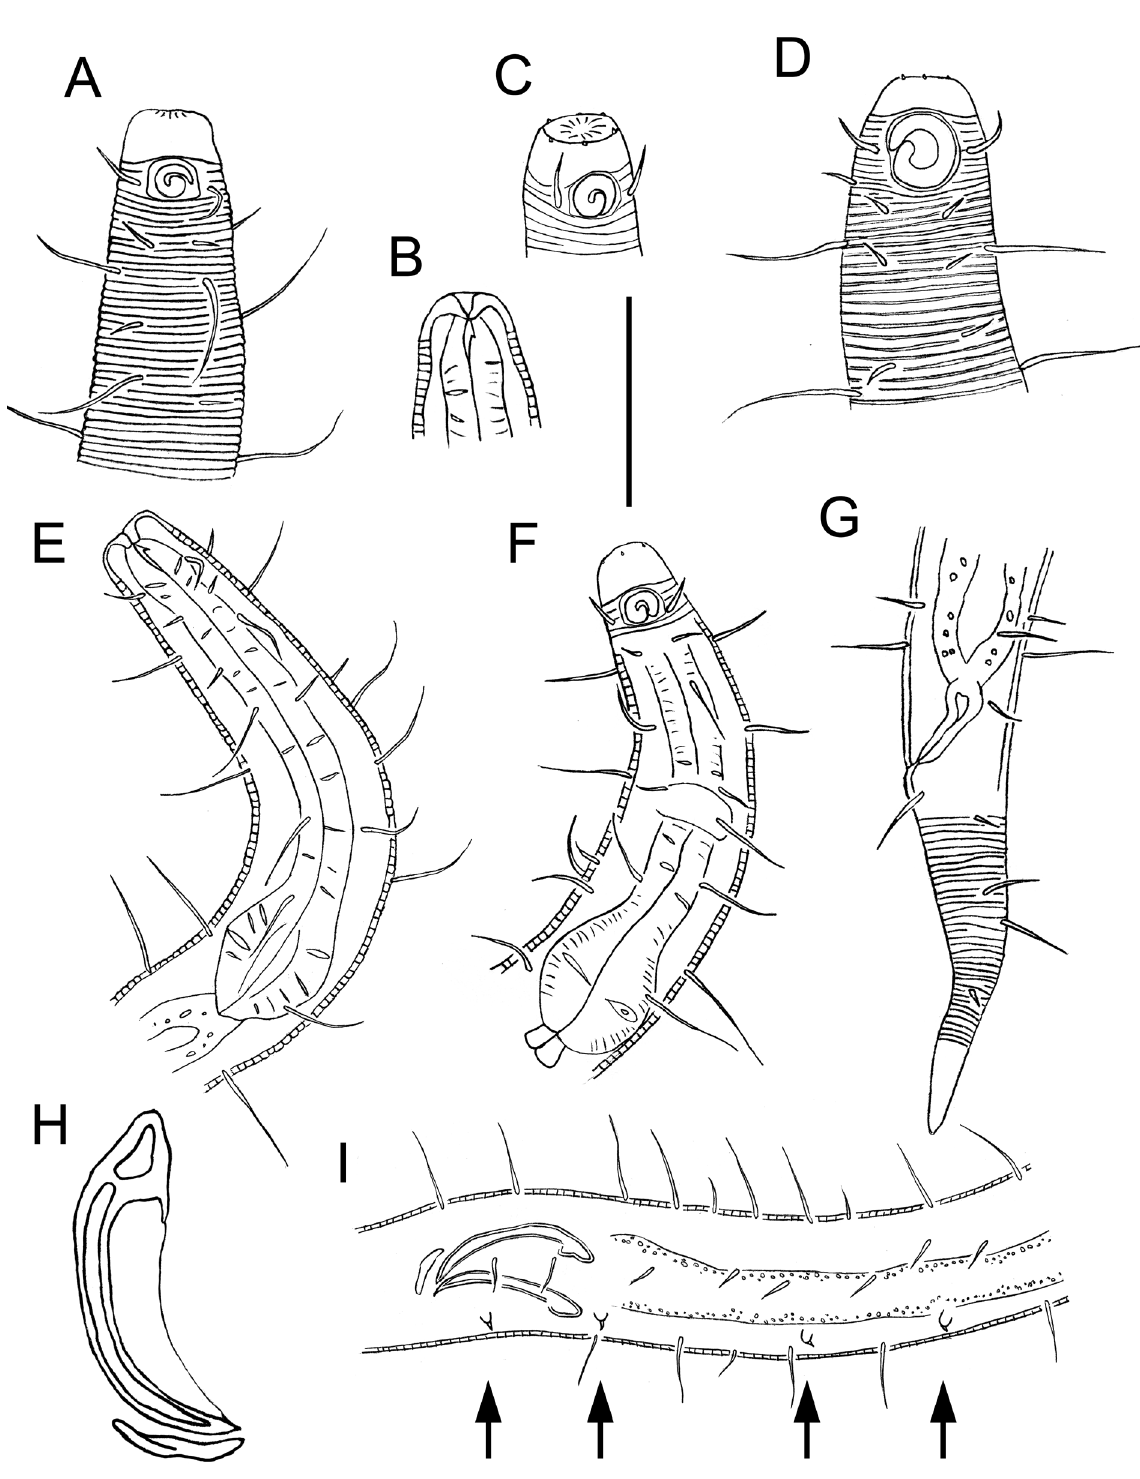
Fig. 4. Stygodesmodora confusa sp. nov. A . Anterior body region of female. B . Male head (holotype). C . Male head (paratype). D . Male head (holotype). E–F . Anterior body region of female. G . Female posterior body region. H . Right spicule and gubernaculum. I . Male copulatory apparatus. Arrows show position of pre-cloacal supplements. Scale bar: A–D = 30 µ m, E–G = 36 µ m, H = 20 µ m, I = 40 µ